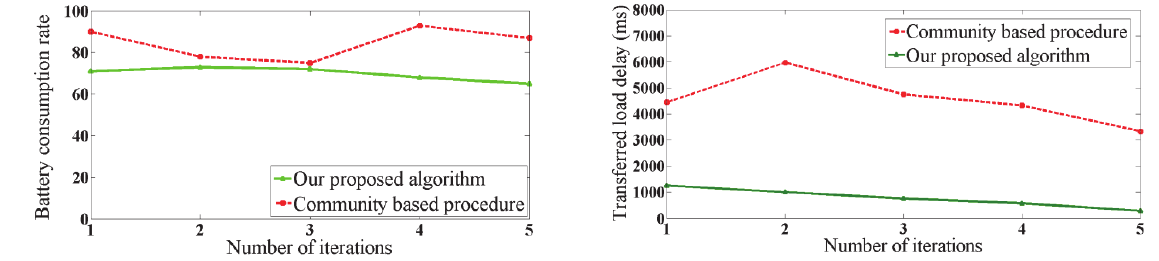
Fig. 3. Rate of battery consumption Fig. 4. Delay during load transfer